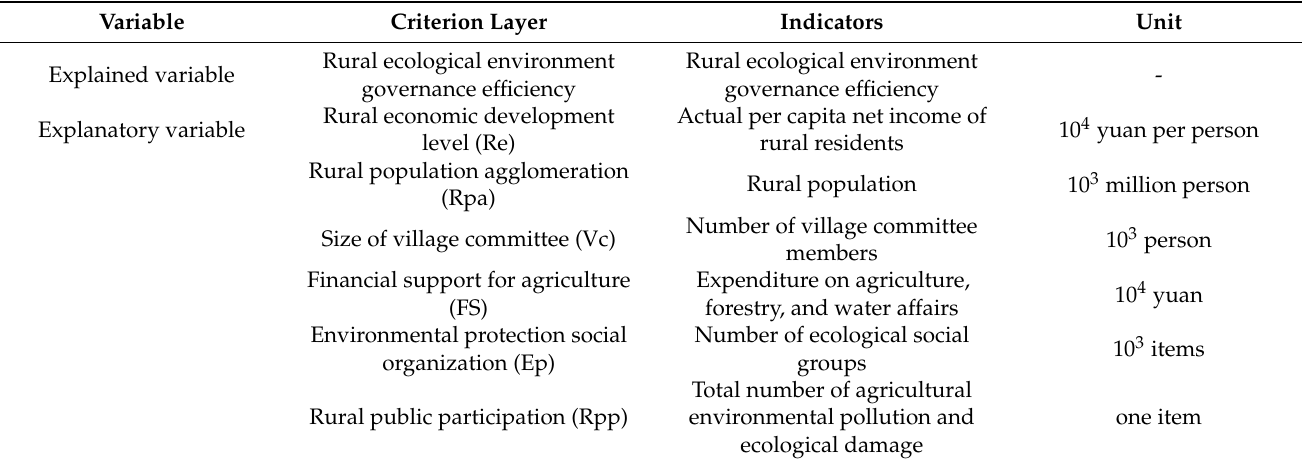
Table 2. Variable